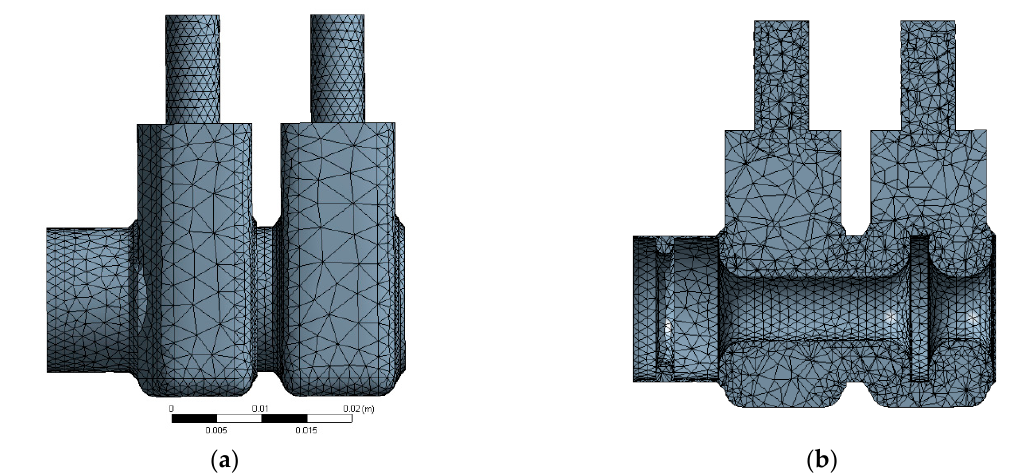
Figure 5. Valve model meshed with ANSYS: ( a ) general view ( b ) view of the cross-section through the axis of symmetry.